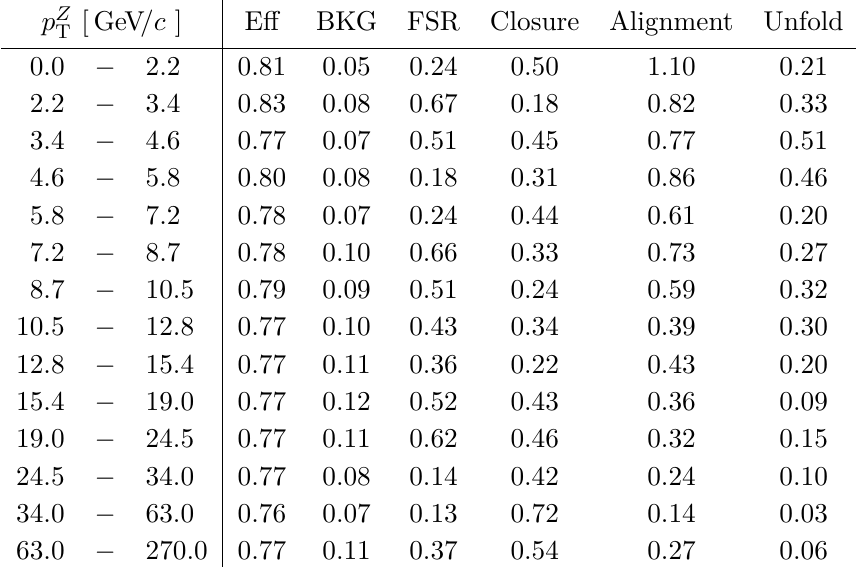
Table 20 . Systematic uncertainties in the single differential cross-sections in interval regions of p Z , presented in percentage. The contributions from efficiency (Eff), background (BKG), final T state radiation (FSR), closure test (Closure), unfolding (Unfold), and alignment and calibration (Alignment) are